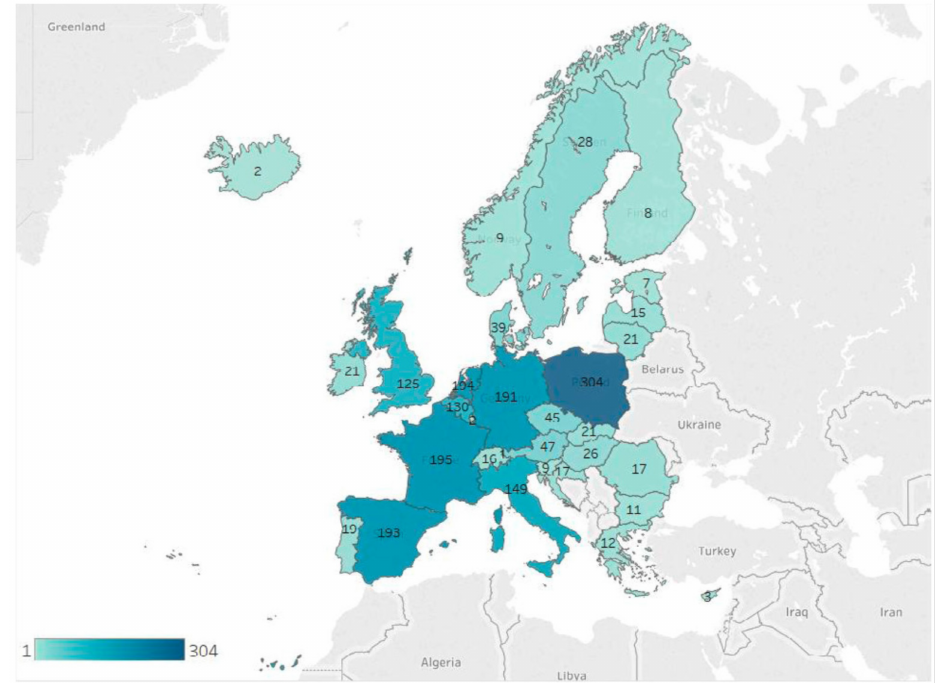
Figure 2. RASFF notifications by RASFF member countries, identified as the origin of the notified product expressed as number of notifications per country of origin in 2019